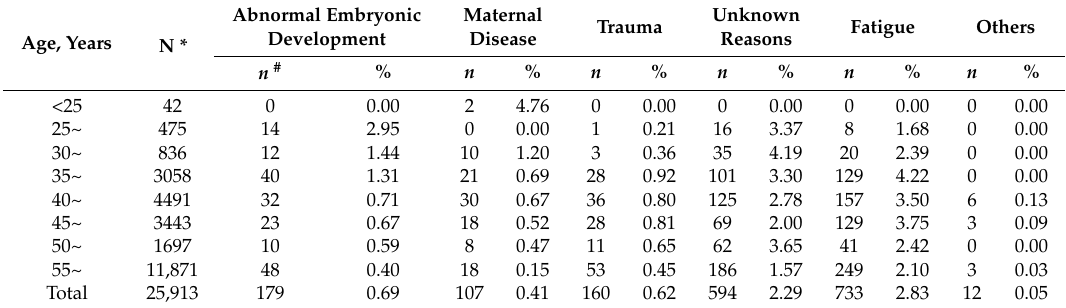
Table 3. Spontaneous Abortion in Different Age Groups in the Jinchang Cohort Study ( n = 18,834). Abnormal Embryonic Maternal Development Disease Age, Years N *